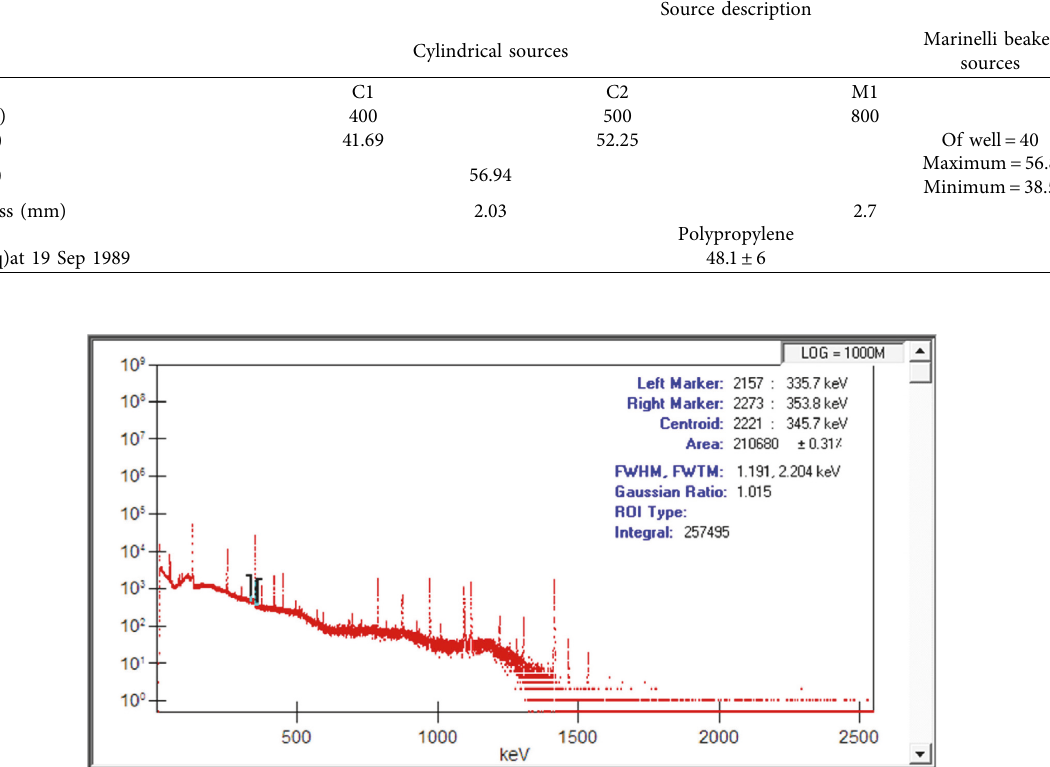
Figure 3: The experimental spectrum using 152 EU volumetric sources in log-scale measured by HPGe detector.